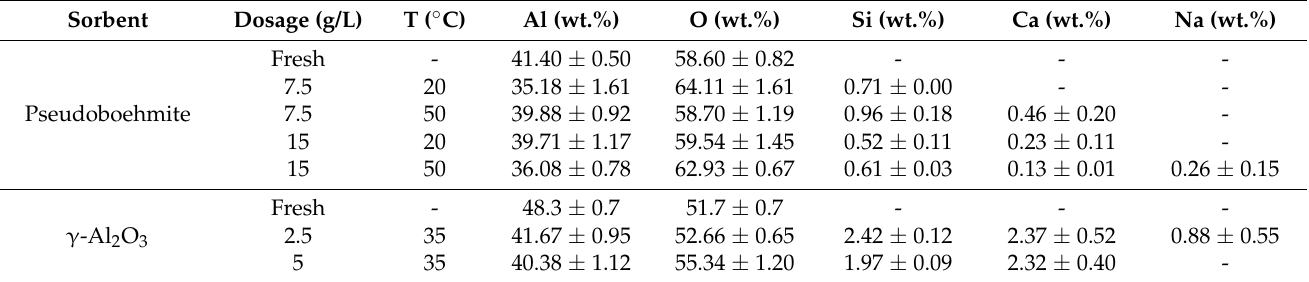
Table 8. Composition of used sorbents by